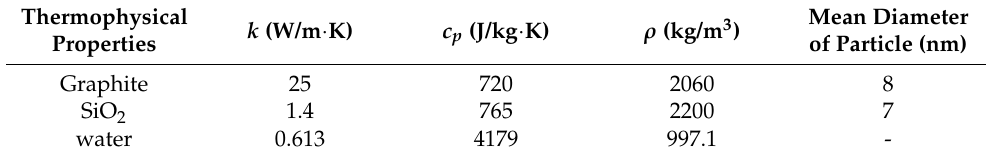
Table 2. Thermophysical properties of base fluid and nanoparticles